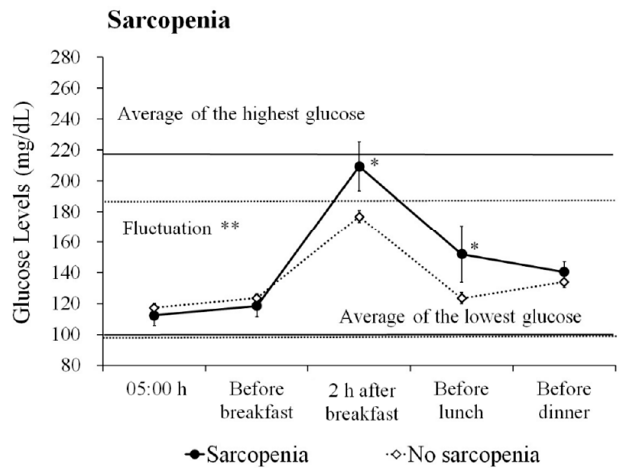
Figure 1. Daily glucose profiles based on sarcopenia. The figure shows the average ± standard error (SE) glucose level based on sarcopenia in all participants. Average of the highest glucose level: the average of the maximum glucose level of the day during the measurement period. Average of the lowest glucose level: the average of the minimum glucose level of the day during the measurement period. The solid line represents the sarcopenia group, and the dotted line indicates the no sarcopenia group. Fluctuation: the average of the diurnal range from the minimum glucose level to the maximum glucose level. ** p < 0.01, * p < 0.05.